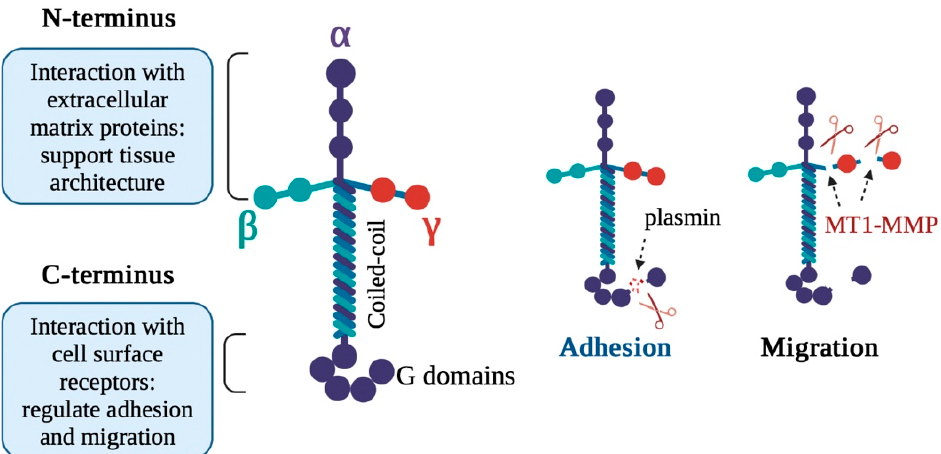
Figure 4. Structure of laminin and its role in cell migration. The N-terminus of laminin stabilizes the structure of cells and tissues following interaction with ECM molecules. The C-terminus of laminin can engage in cell movements. Cleavage of the α subunit leads to the enhanced attachment of cells to the matrix, whereas proteolysis of the γ subunit by MT1-MMP promotes the detachment of cells from the matrix, triggering migration.